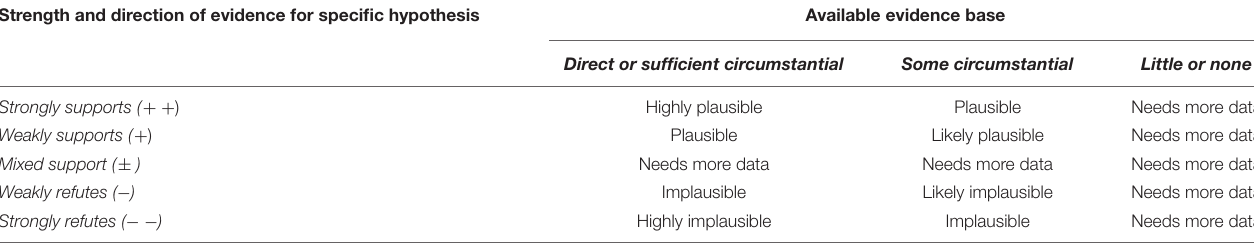
TABLE 2 | Framework used to assess plausibility of each hypothesis explaining driver of decline in sea snake populations using data from Ashmore Reef Marine Park as a case study. Strength and direction of evidence for specific hypothesis